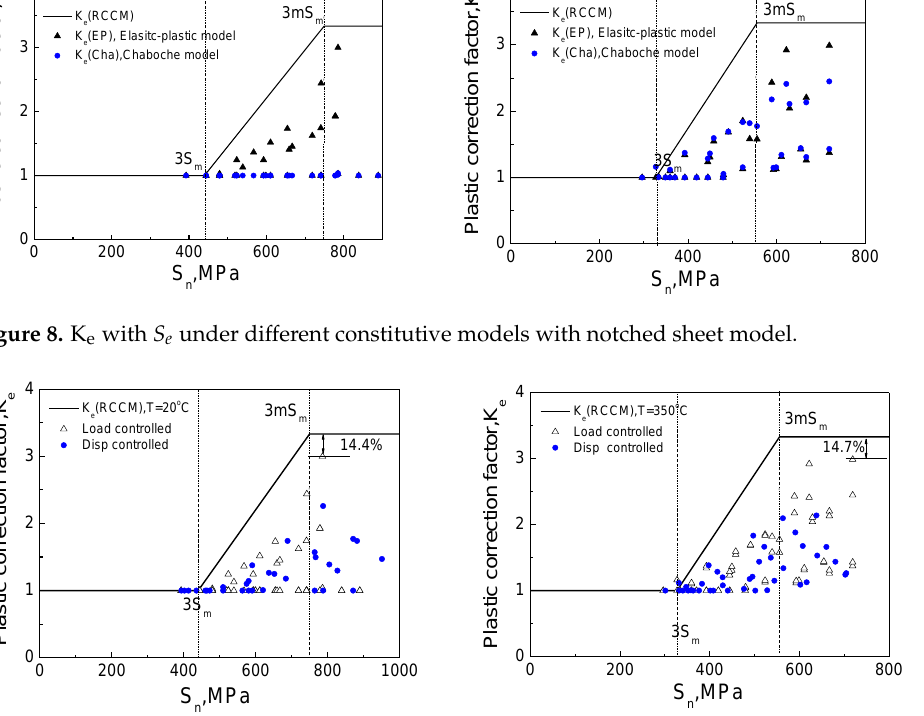
Figure 8. K e with S n under different constitutive models with notched sheet model.